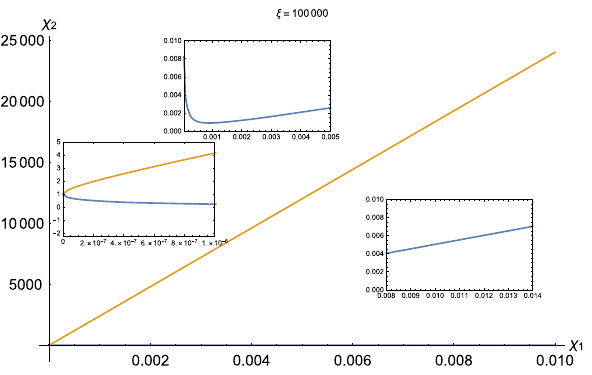
Fig. 4 Demonstrating the phantom boundaries in some differ- ent regions and scales. The blue curve corresponds to χ 2 = (cid:8) (cid:4) (cid:5) − χ ξ + χ + 1 and the orange + 12 χ 72 ξ 2 χ 1 + 6 (χ 1 + 2 )ξ − χ 1 1 1 1 (cid:8) (cid:4) (cid:5) χ ξ + χ + 1 + 12 χ curve to χ 2 = 72 ξ 2 χ 1 + 6 (χ 1 + 2 )ξ − χ 1 1 1 1 whicharetherootsof ˙ H = 0.Aswehavediscussedinthetext,although the point (χ 1 = 0 ,χ 2 = 1 ) is a branching point for the above curves